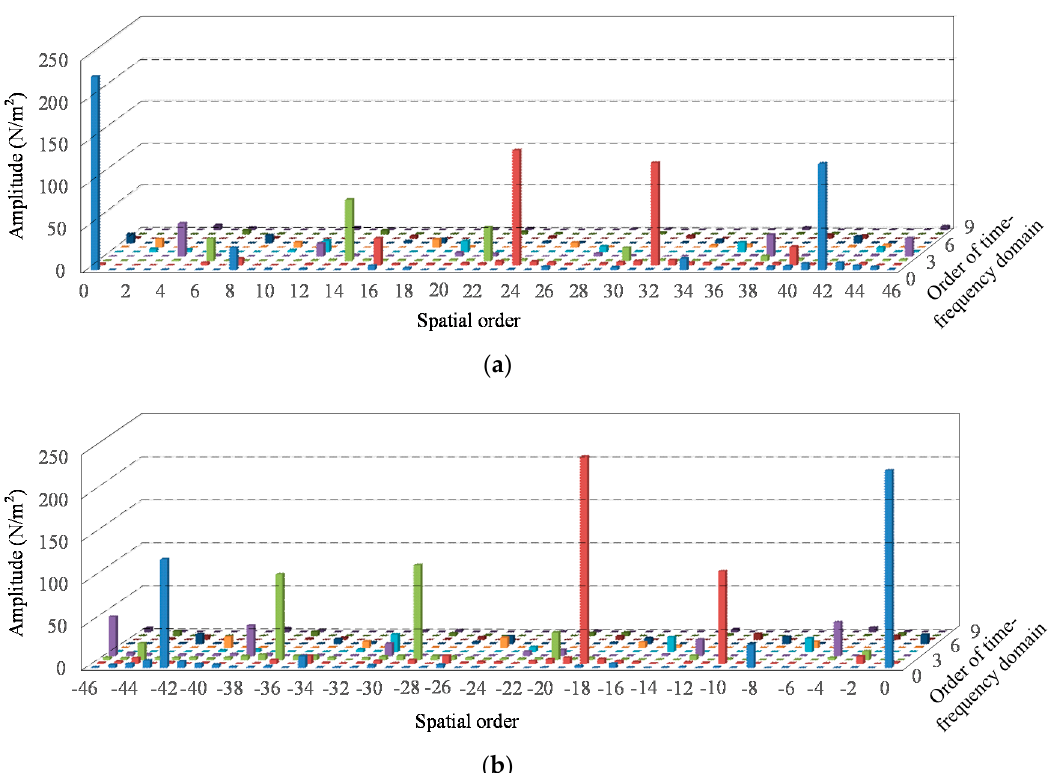
Figure 5. Orders of radial electromagnetic force: ( a ) Forward rotation; ( b ) Reverse rotation.